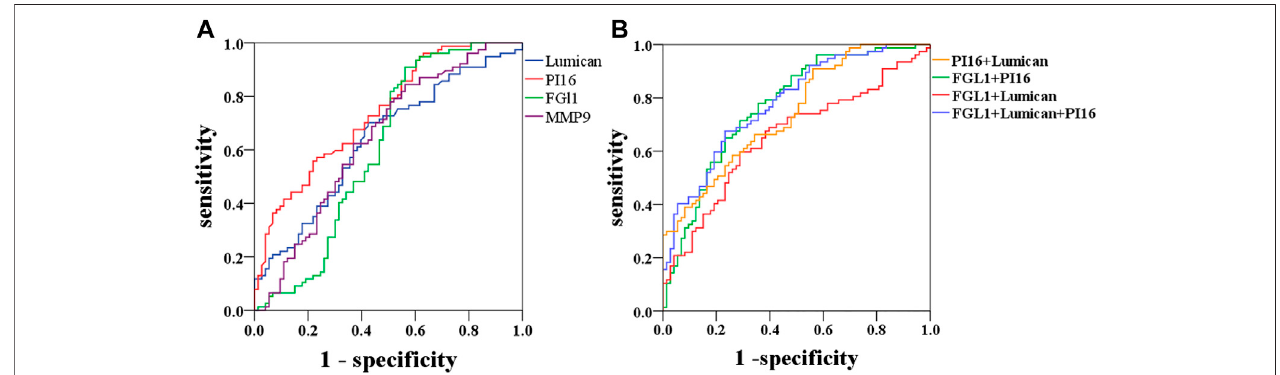
FIGURE 6 | Diagnostic outcomes in the discovery phase are shown via the receiver operating characteristic curve (ROC) curves for PI16, MMP9, and FGL1 to discriminate AAD from controls, p < 0.05. PI16 indicates peptidase inhibitor 16, FGL1 indicates fi brinogen-like protein 1, and MMP9 indicates matrix metalloproteinase-9.